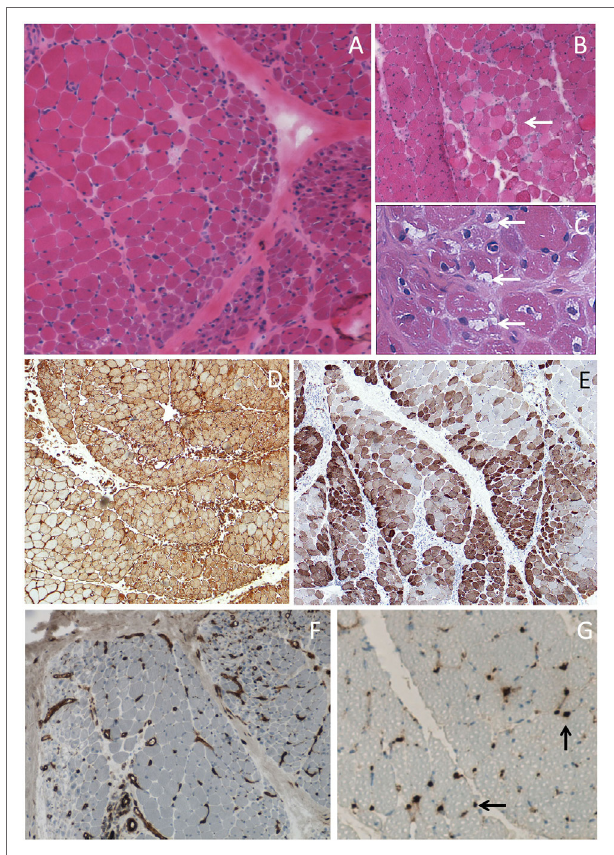
FigURe 2 | Muscle biopsy of dermatomyositis. (A) Perifascicular atrophy. (B) Area of contiguous necrotic myofibers (arrow) corresponding to a microinfarct. (C) Punch-out vacuoles within myofibers (arrows) assessing focal myosinolysis. (D) Ubiquitous myofiber reexpression of MHC-class I with perifascicular reinforcement. (e) Neural cell adhesion molecule (NCAM) immunostaining showing large areas of positive myofibers indicating muscle ischemia. (F) Platelet endothelial cell adhesion molecule (PECAM) immunostaining for endothelial cells showing marked endomysial capillary drop out. (g) Complement activation assessed by the presence of membrane attack complex deposits at the level of endomysial capillaries (arrows). Frozen sections, light microscopy; hematoxylin-eosin (A–C) , immunoperoxydase technique (D–g) , HLA-ABC (D) , CD56/NCAM (e) , CD31/PECAM (F) , and C5b-9 (g)